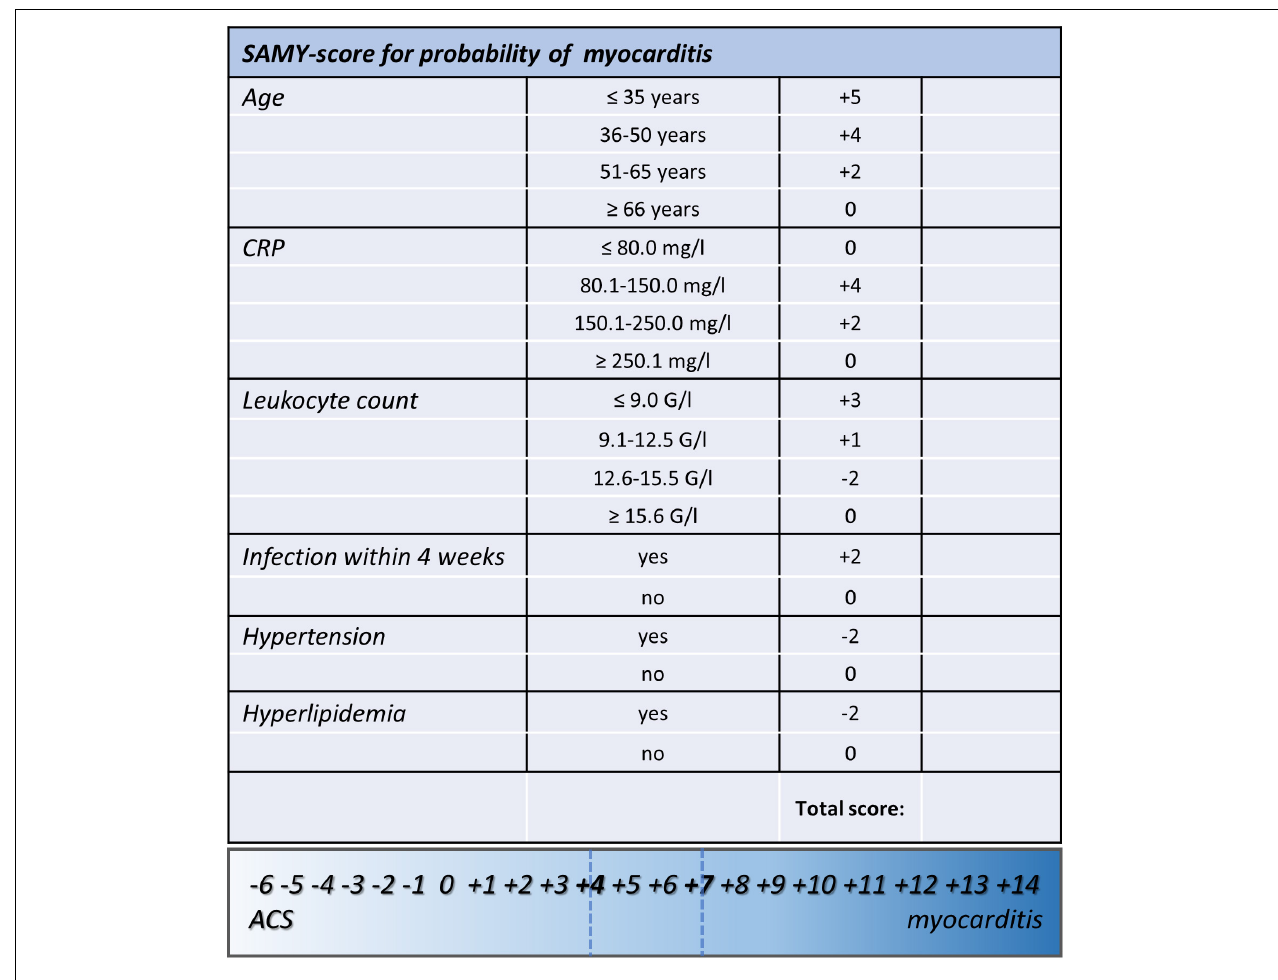
FIGURE 1 | Score sheet of the proposed clinical score for the prediction of myocarditis that includes the two calculated cutoffs (#1: ≥ 4, Sens.: 90.3%, Spec.: 93.1%, PPV: 87.5%, NPV 94.7%; 46.3% predicted probability for myocarditis; #2: ≥ 7, Sens.: 73.1%, Spec.: > 99.9%, PPV: > 99.9%, NPV 87.4%; 92.9% predicted probability for myocarditis). SAMY, SAlzburg MYocarditis score; ACS, acute coronary syndrome; BMI, body mass index; CRP, C-reactive protein.